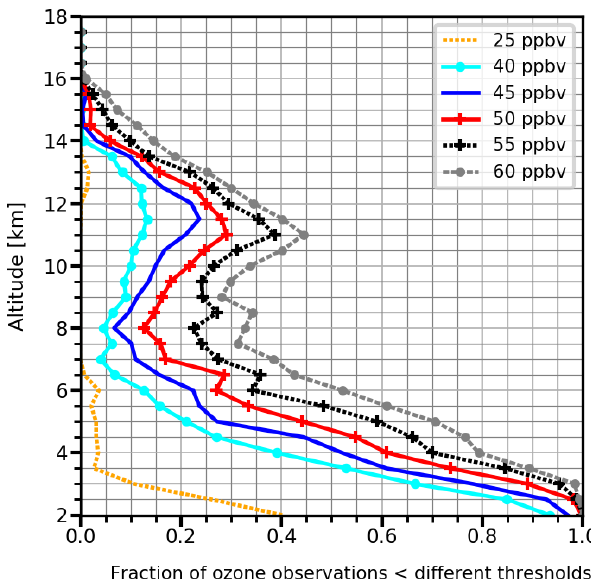
Figure 7. Vertical profiles of frequency of occurrence of ozone mix- ing ratios below 25, 40, 45, 50, 55 and 60ppbv at Réunion island for austral summers (NDJFMA) 2014, 2015 and